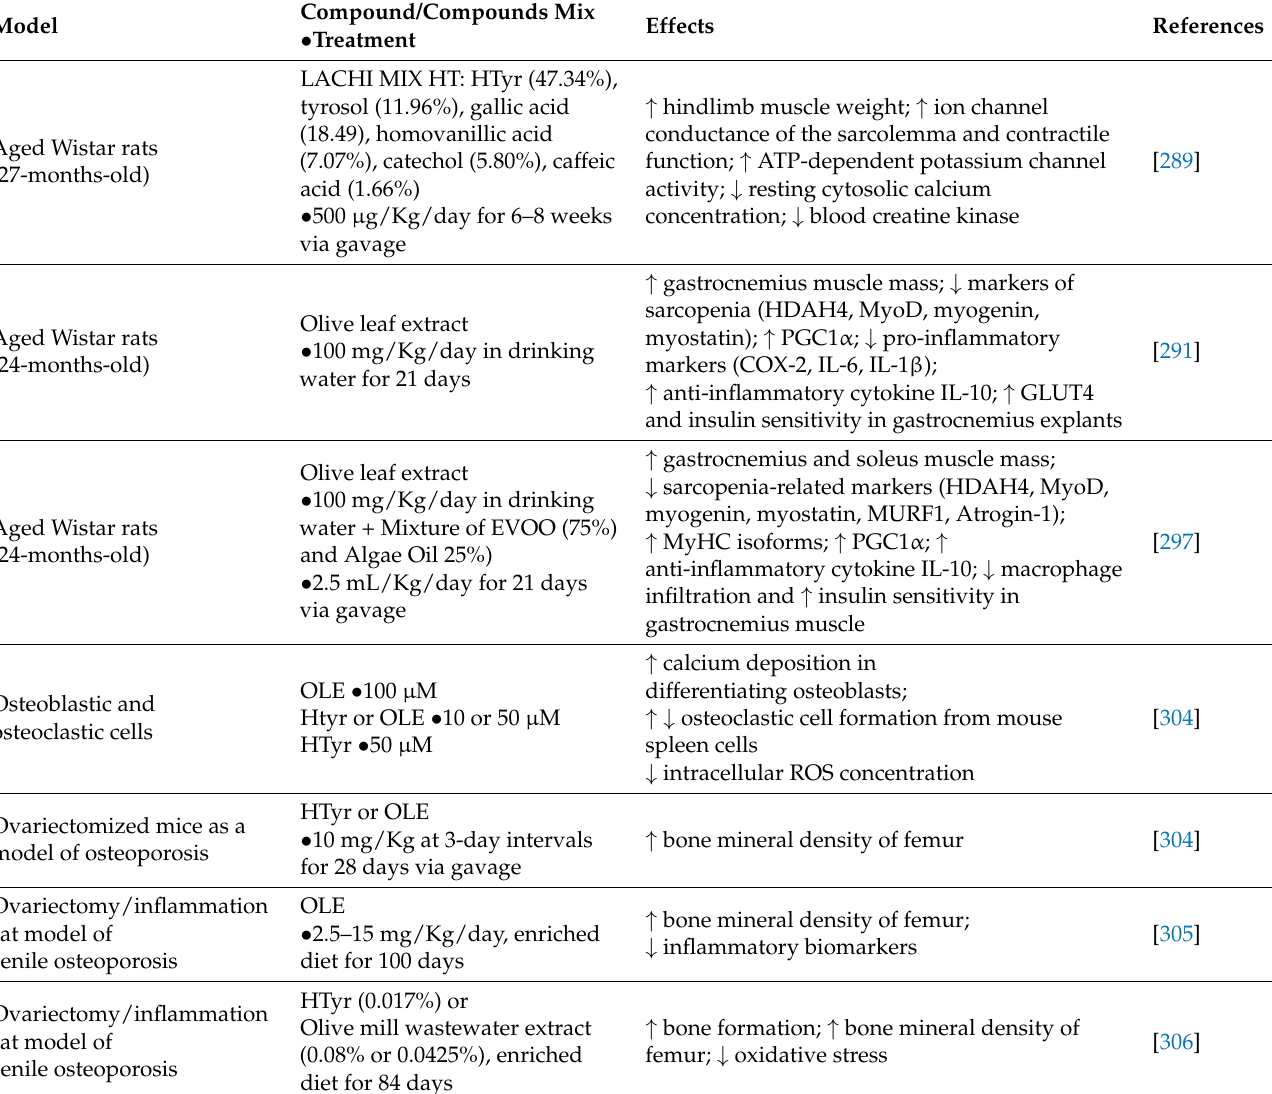
Table 4. Effects of HTyr or OLE on skeletal muscle atrophy and osteoporosis and skeletal muscle insulin